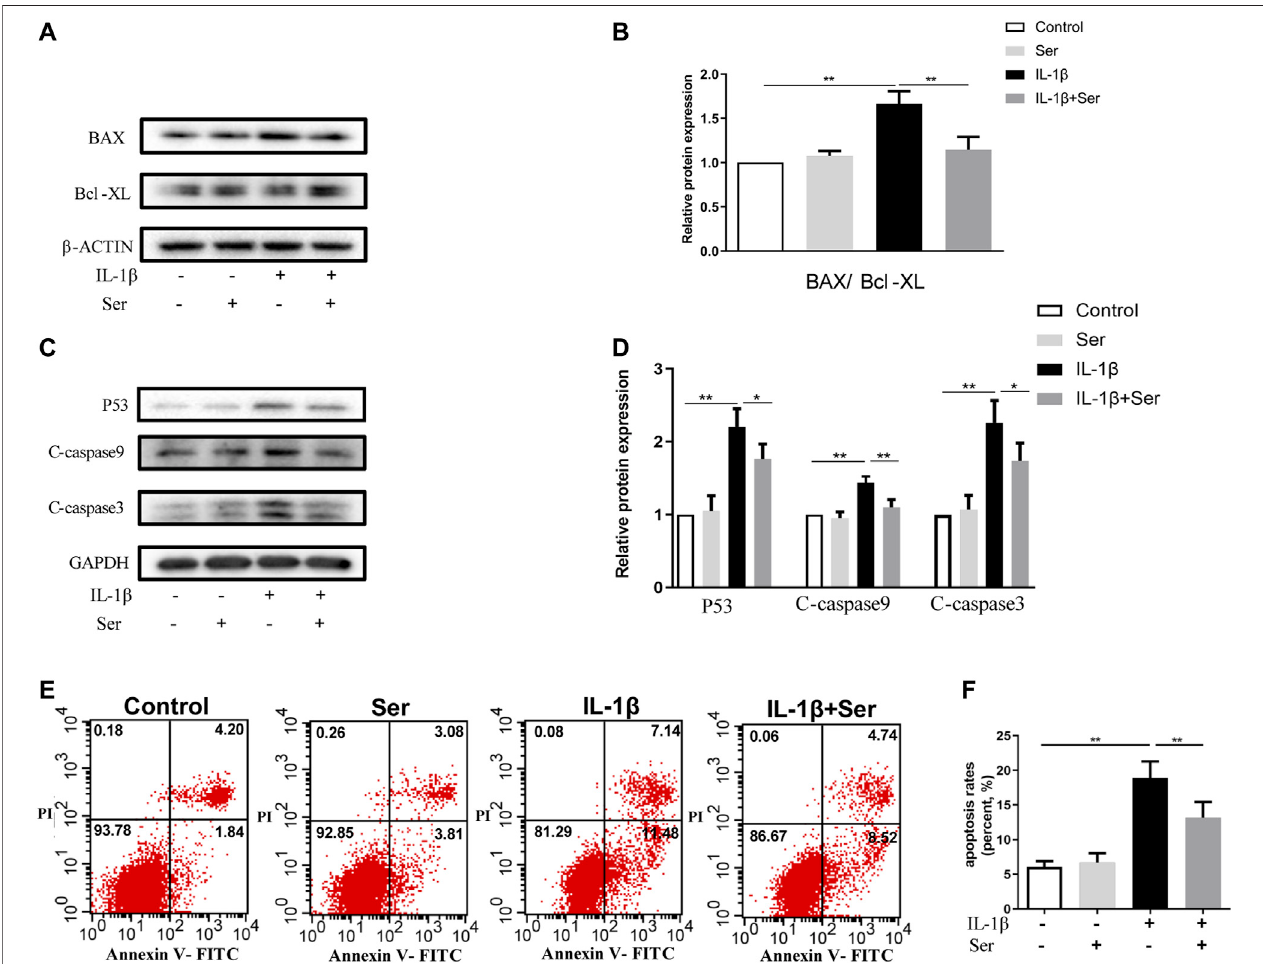
FIGURE3| SeramelioratesIL-1 β -inducedapoptosisinratchondrocytes.CellsweretreatedwithSer(25 μ M)aloneorincombinationwithIL-1 β (10 ng/ml)for24 h. (A) Western blot of the expression of BAX, Bcl-XL (B) quantitative analysis BAX/Bcl-XL. (C) Western blot and (D) quantitative analysis of P53, C-caspase9 and C-caspase3. GAPDH was used as the loading control. (E) Apoptotic cells were detected with Annexin V-FITC/PI staining and fl ow cytometry. (F) Quantitative of the apoptosis rates of each group. p p < 0.05, pp p < 0.01, n (cid:2) 3.